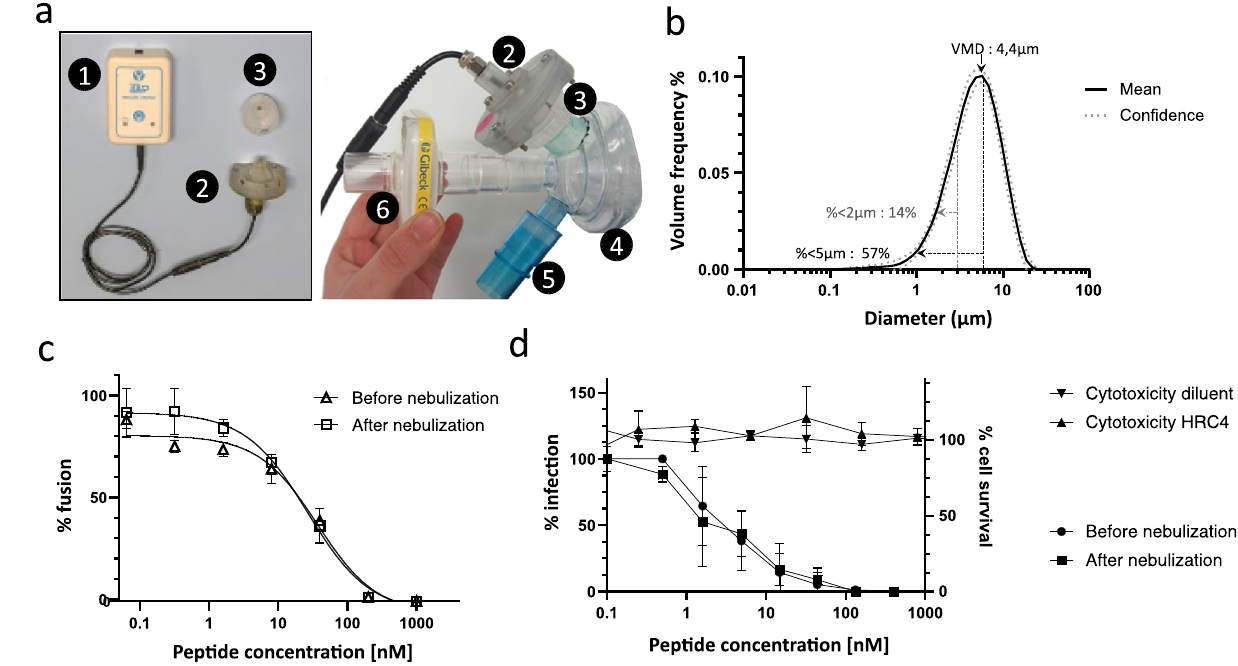
Fig. 2 | Utilization of the prototype mesh nebulizer with low Volume Medium Diameter preserves functional activityofHRC4 lipopeptide. a Composition of the prototype mesh nebulizer used in experiments: 1. electronic controller; 2. piezo-electric vibrator; 3. reservoir containing the mesh; 4. facemask; 5. one- way inspiratory valve; 6. absolute fi lter. b Graphical representation of particle size distribution obtained from laser diffraction analysis of aerosolized 3ml of HRC4 lipopeptide. Plain line presents the mean values of four different nebulizers used in the study and dotted line standard deviation. Percentage of particles <5 µ m and <2 µ m present the fraction of aerosol below the indicated size, corresponding to the aerosol penetrating into either lung in general